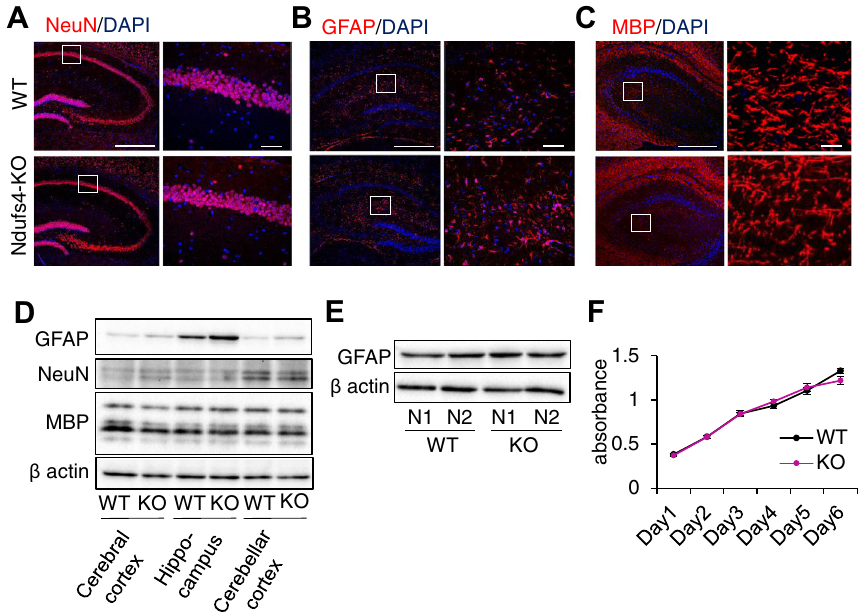
Figure 2. Ndufs4 deficiency shows astrocyte reactivity in hippocampus displaying normal GFAP expression and proliferation in primary culture of astrocyte. ( A – C ) Representative image from immunofluorescence staining of NeuN ( A ), GFAP ( B ) and MBP ( C ) in hippocampus of WT and Ndufs4-KO mouse. Boxed area is enlarged on right. Scale for low magnification: 500 µm, for high magnification: 50 µm. ( D ) Representative image of Western blot for GFAP, NeuN and MBP in different regions of WT and Ndufs4-KO mouse brain. ( E ) Representative image of Western blot for GFAP in WT and Ndufs4-KO primary astrocytes. ( F ) Proliferation assay of WT (n = 6) and Ndufs4-KO (n = 6)